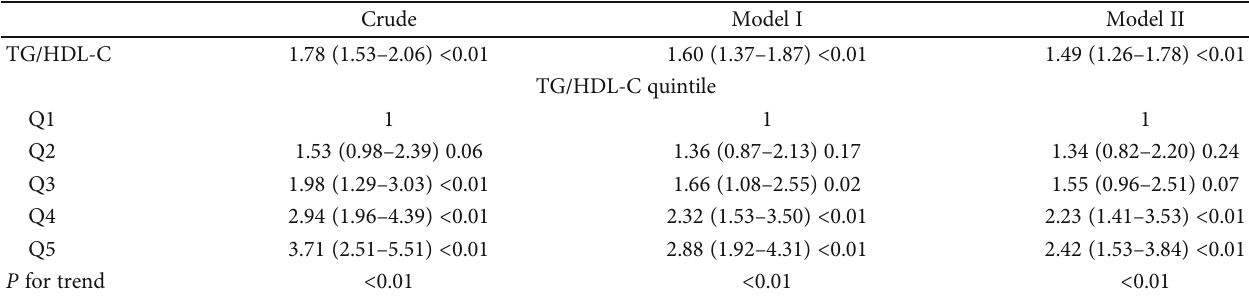
Table 2: Association between serum TG/HDL-C and the incidence of T2DM in the REACTION study. Crude Model I Model II